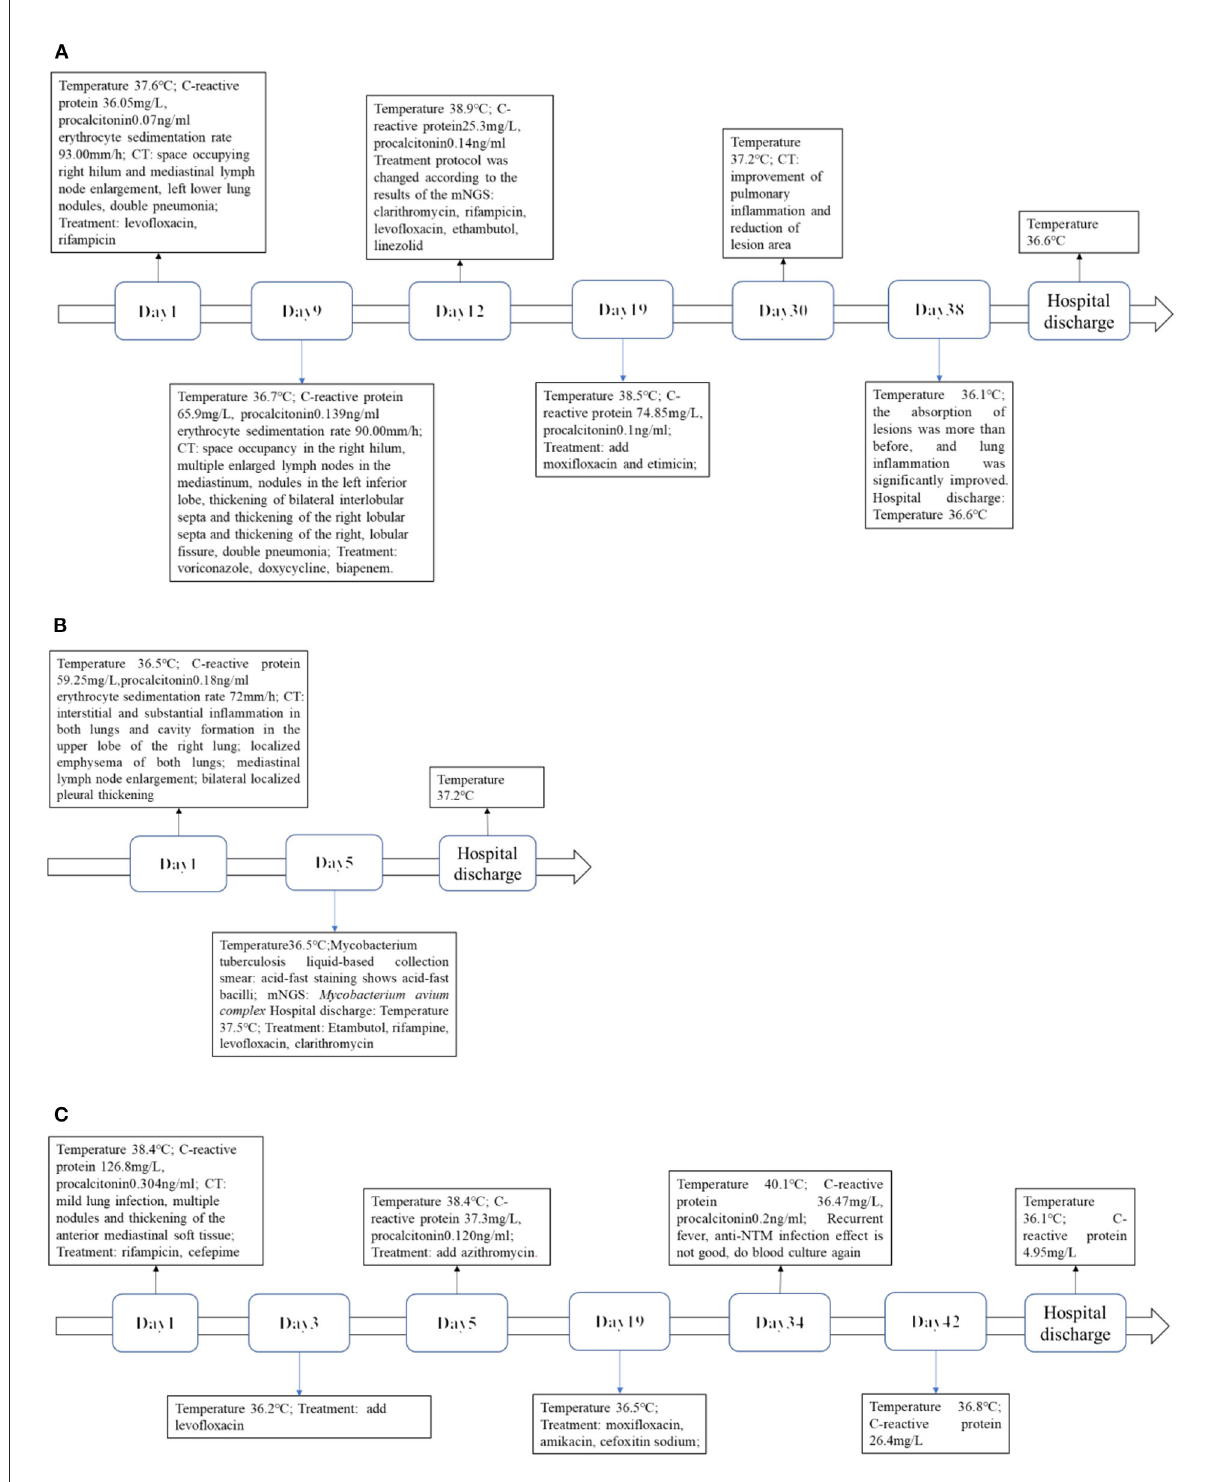
FIGURE6 (A) Case 1. Timeline of infection progression. (B) Case 2. Timeline of infection progression. (C) Case 3. Timeline of infection